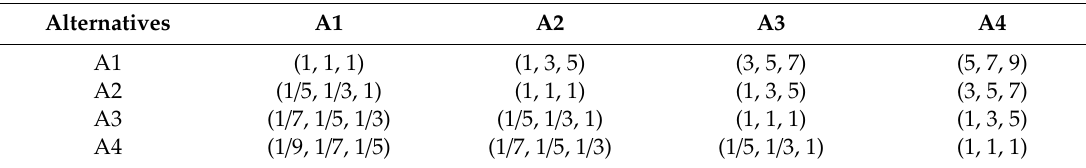
Table 5. Evaluation with respect to implementation time.